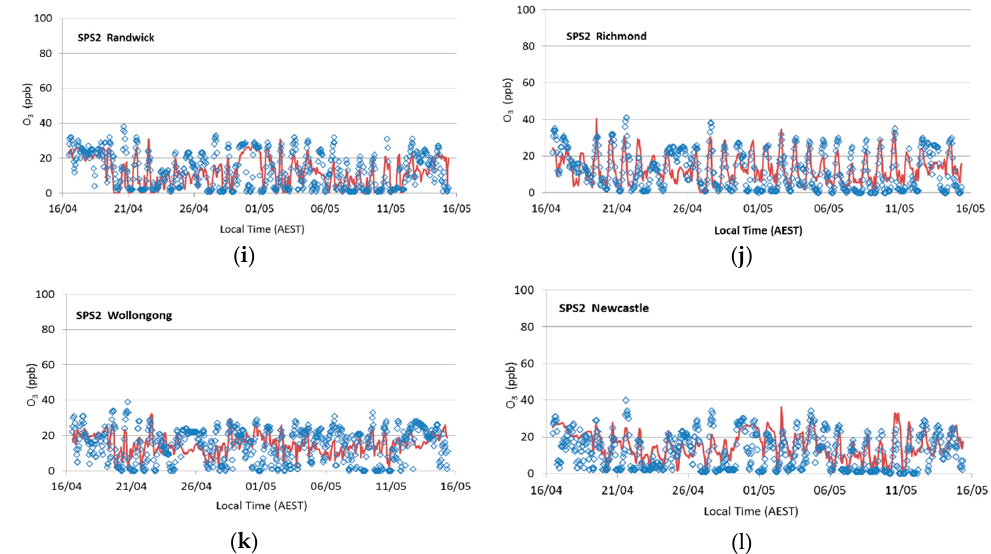
Figure 10. The time series of predicted (red line) and observed (blue hollow dot) hourly O 3 (ppb) at selected six OEH stations during: SPS1 ( a – f ); and SPS2 ( g – l ). The spatial distribution of predicted average hourly O 3 and average daily maximum O 3 concentrations for the SPS1 and SPS2 periods are shown in Figure 11. In the summer months during SPS1 (Figure 11a), areas of higher average ozone concentrations (18 ppb) are found over the Blue Mountains National Park (100 km west of Sydney) as well as the Wollemi National Park (200 km northwest of Sydney). In the autumn months during SPS2, generally lower than average ozone concentrations are found across Sydney (Figure 11b) compared to that in SPS1. It should be noted that an area of elevated ozone is found over the ocean east of Sydney in both SPS1 and SPS2. There are no surface ozone observations over the ocean to compare with at this stage, however, the possible high ozone may be due to lack of local sources of NOx over the ocean, which leads to less surface deposition. The spatial distribution of O 3 daily maximum concentrations averaged for the period of SPS1 and SPS2 are illustrated in Figure 11c,d. It clearly demonstrates the higher peak hourly ozone tend to occur in the Sydney Northwest region and the Wollemi National Park region during summer months (Figure 11c). Peak hourly ozone significantly decreases during autumn months (Figure 11d), however, the reginal maximum still can be found in the Sydney NW region.